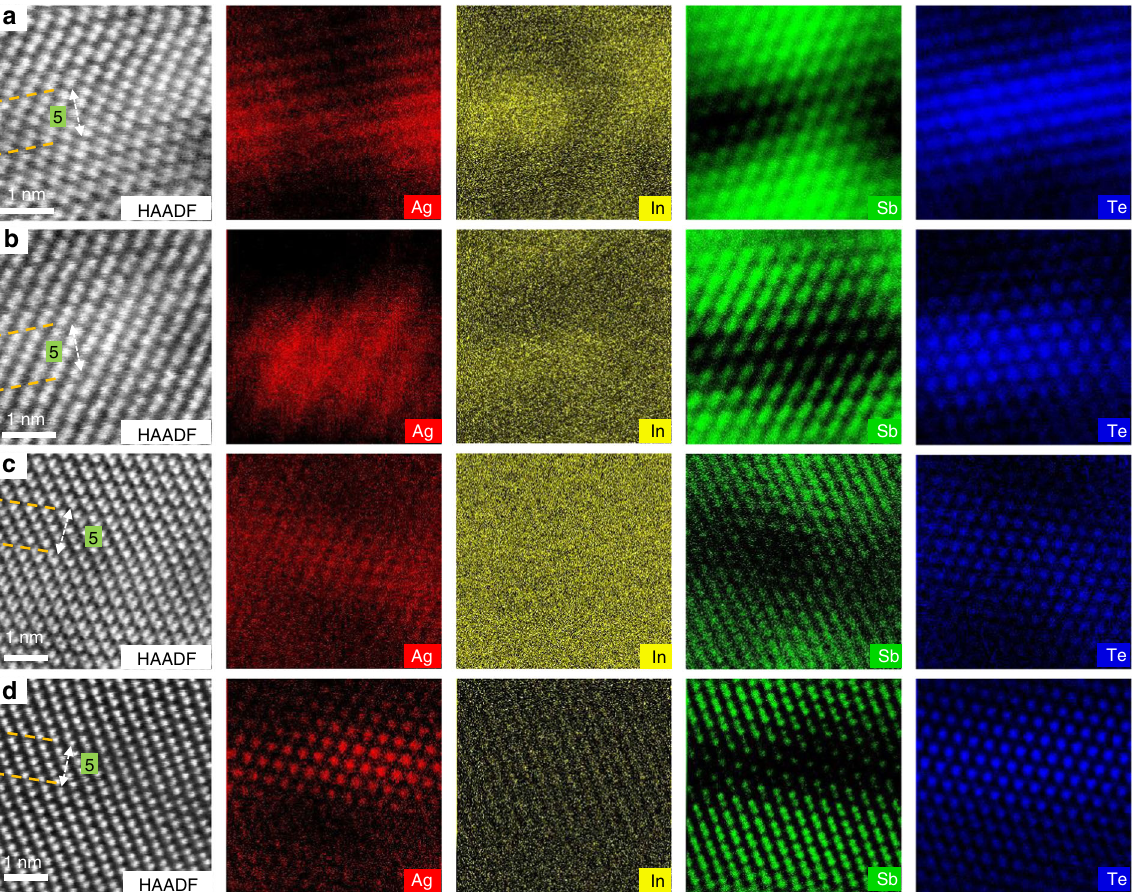
Fig. 1 Atomic structure of crystalline AIST annealed at different temperatures. a ‒ d HAADF-STEM images, and corresponding EDX mappings of Ag, In, Sb and Te elements annealed at 200, 250, 300, and 350 °C, respectively. The scale bar is 1